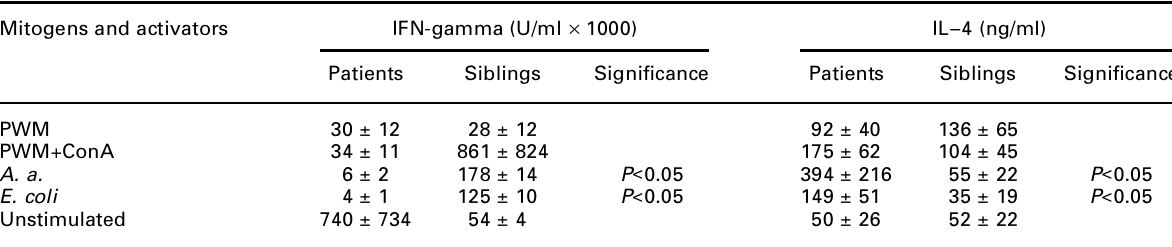
Table 1. +Release of IFN-gamma and IL–4 after the stimulation (24h) of PBMC by mitogens and antigens a